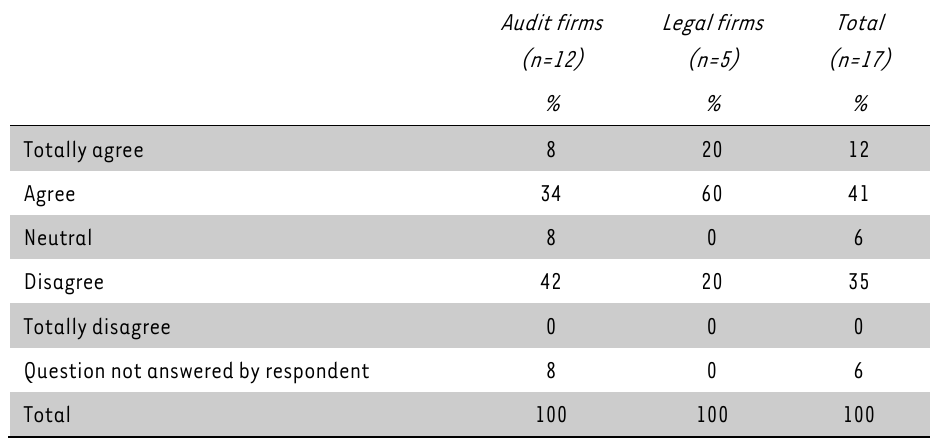
TABLE 10: Results of Question